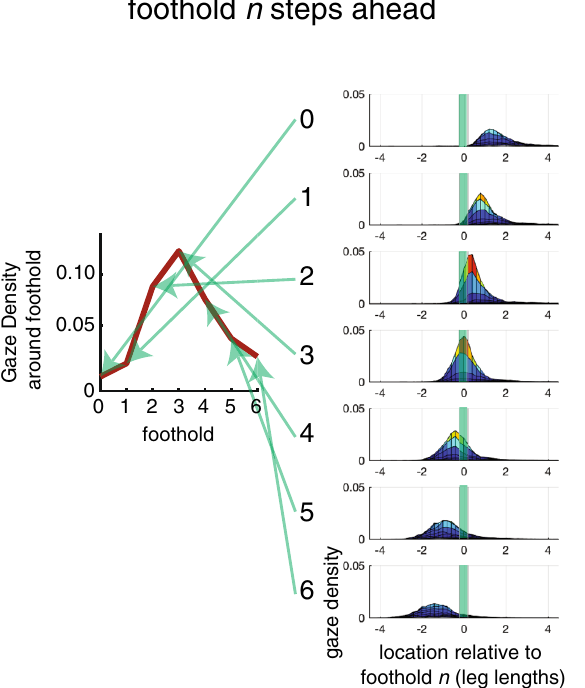
Figure 6. Calculating gaze density relative to nth foothold. The gaze density around upcoming footholds is the integral of the gaze density within 0.3 leg lengths of the origin in each foothold-centered reference frame (Bottom panels, numbered 0–6). The summary panel (Top) shows the gaze densities as a function of foothold and thus provides a relative measure of the gaze allocated to that foothold during walking in a particular